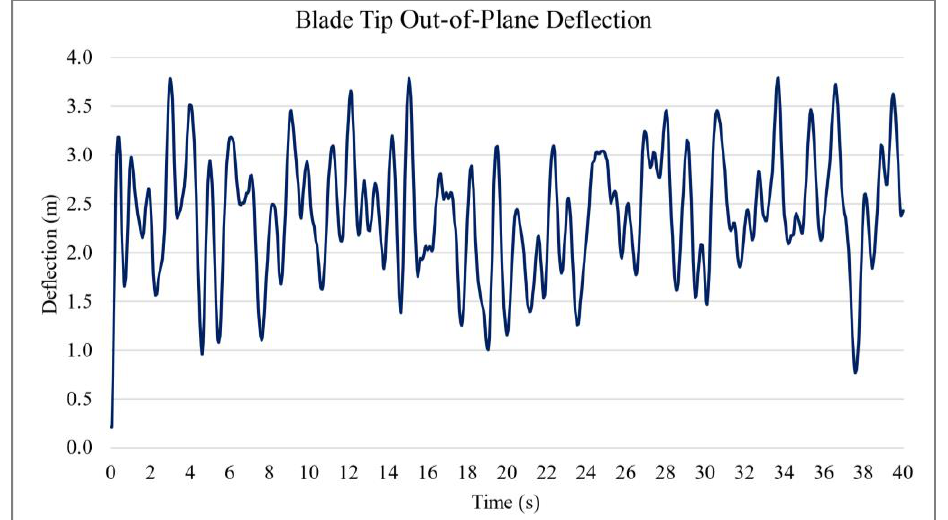
Figure 7. Blade Tip Out-of-Plane Deflection - 50% Turbulence